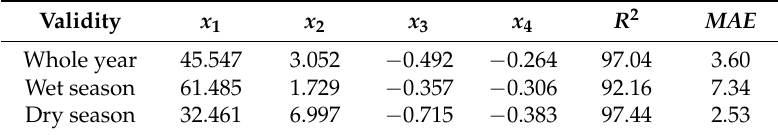
Table 1. Results of the calibration of the surrogate models.